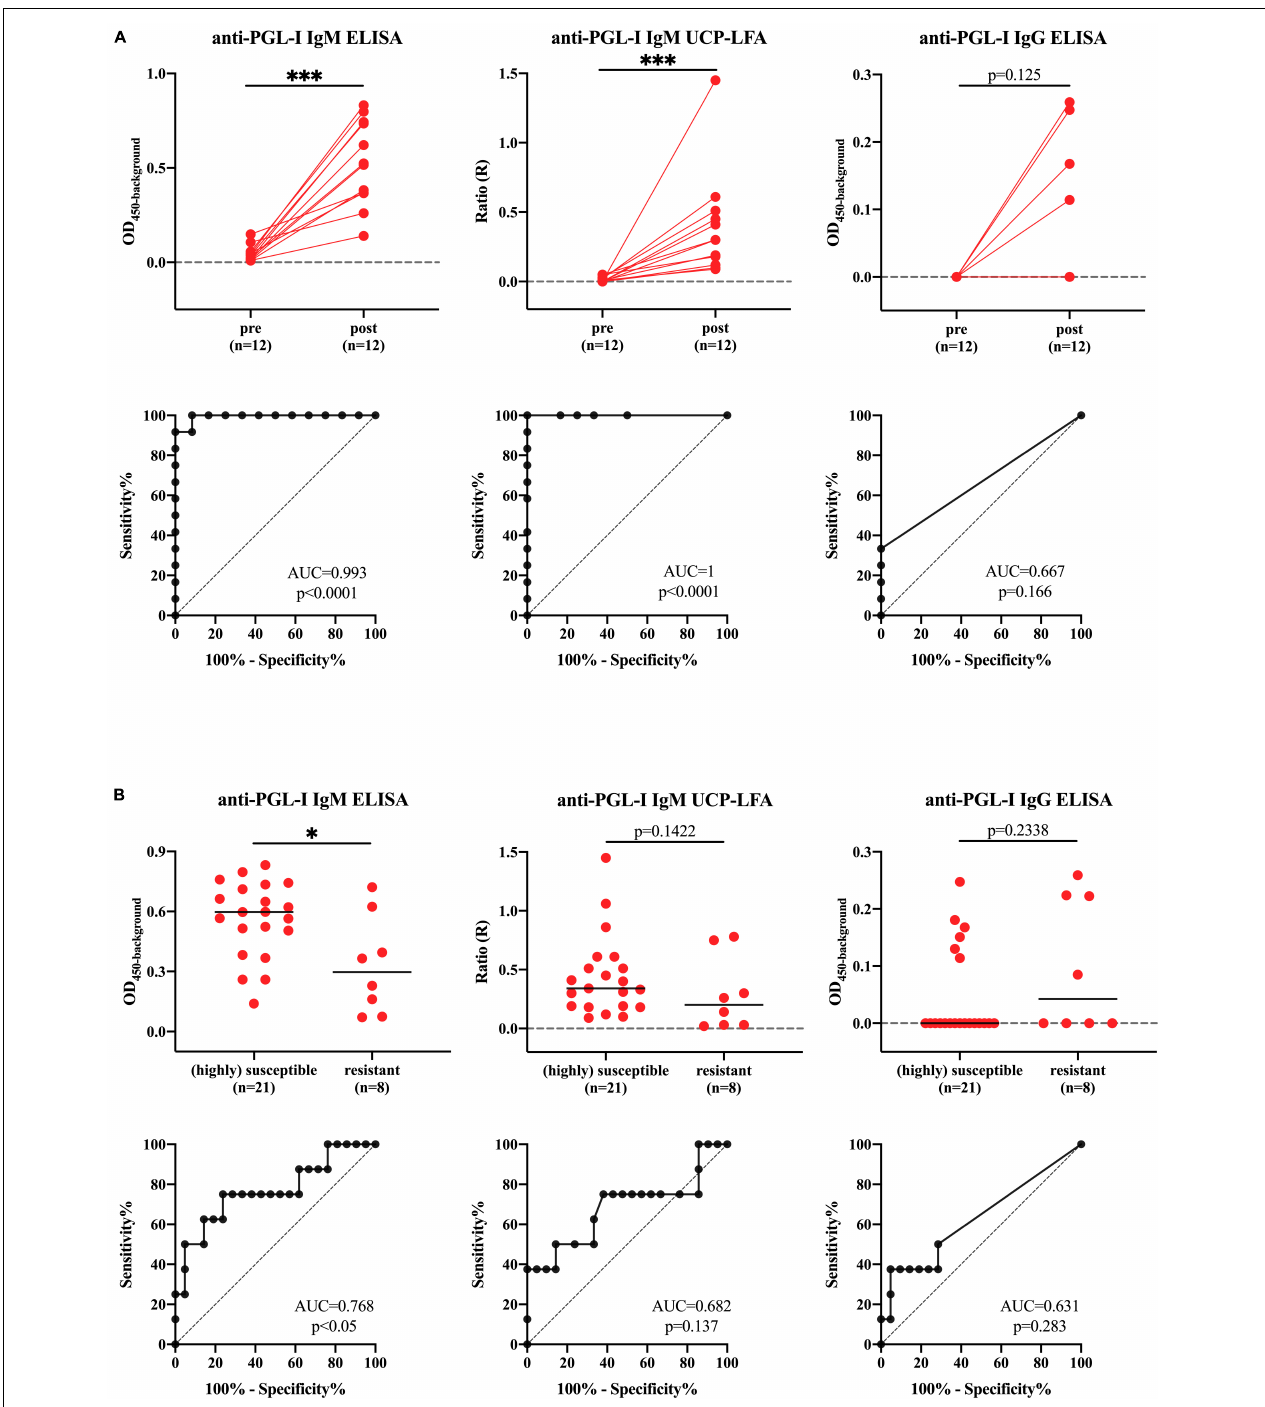
FIGURE 5 | Differences in anti-PGL-I antibody levels between uninfected- and M. leprae infected highly susceptible, susceptible and resistant armadillos. Anti-PGL-I antibody levels were measured by UCP-LFA (IgM) and ELISA (IgM/IgG) in serum from armadillos infected with 1 × 10 9 M. leprae bacilli of the following strains: NHDP 63 ( n = 9), NHDP 98 ( n = 4), or Brazil 4923 ( n = 4). Samples were analyzed pre-infection (t i ) for all animals ( n = 21) and post-infection (t c /t m /t l /t s ) for highly susceptible ( n = 7), susceptible ( n = 4) and resistant ( n = 6) armadillos UCP-LFA results are displayed as the Ratio value (R; y -axis) between Test (T) and Flow-Control (FC) signal; ELISA results are displayed as optical density at 450 nm corrected by the background for each sample (OD 450 - background ). (A) For animals for which both samples were available, significant differences between levels in pre (t i )- vs. post (t s )-infection sera were determined by Wilcoxon matched-paired tests; (B) Antibody levels in all sera after inoculation were determined by Mann-Whitney U -tests; P -values: ∗ p < 0.05, ∗∗∗ p < 0.001. t i : time of inoculation; t c : time of seroconversion (for highly susceptible and susceptible animals); t m , mid-stage disease; t l , late-stage disease; t s , time at sacrifice.